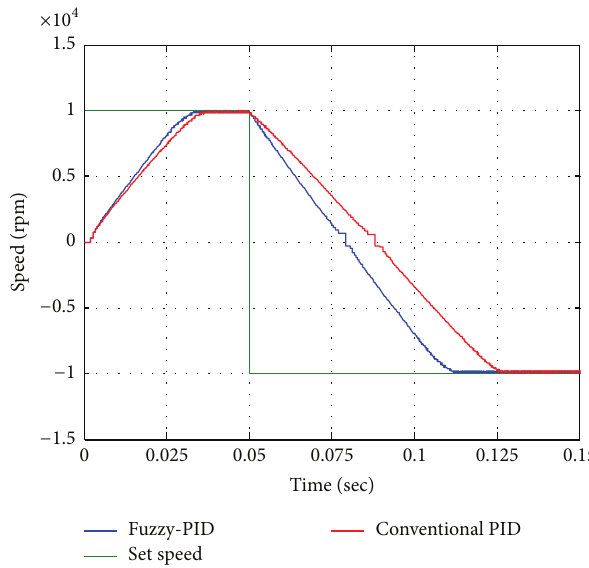
Figure 15: Speed reversal performances.